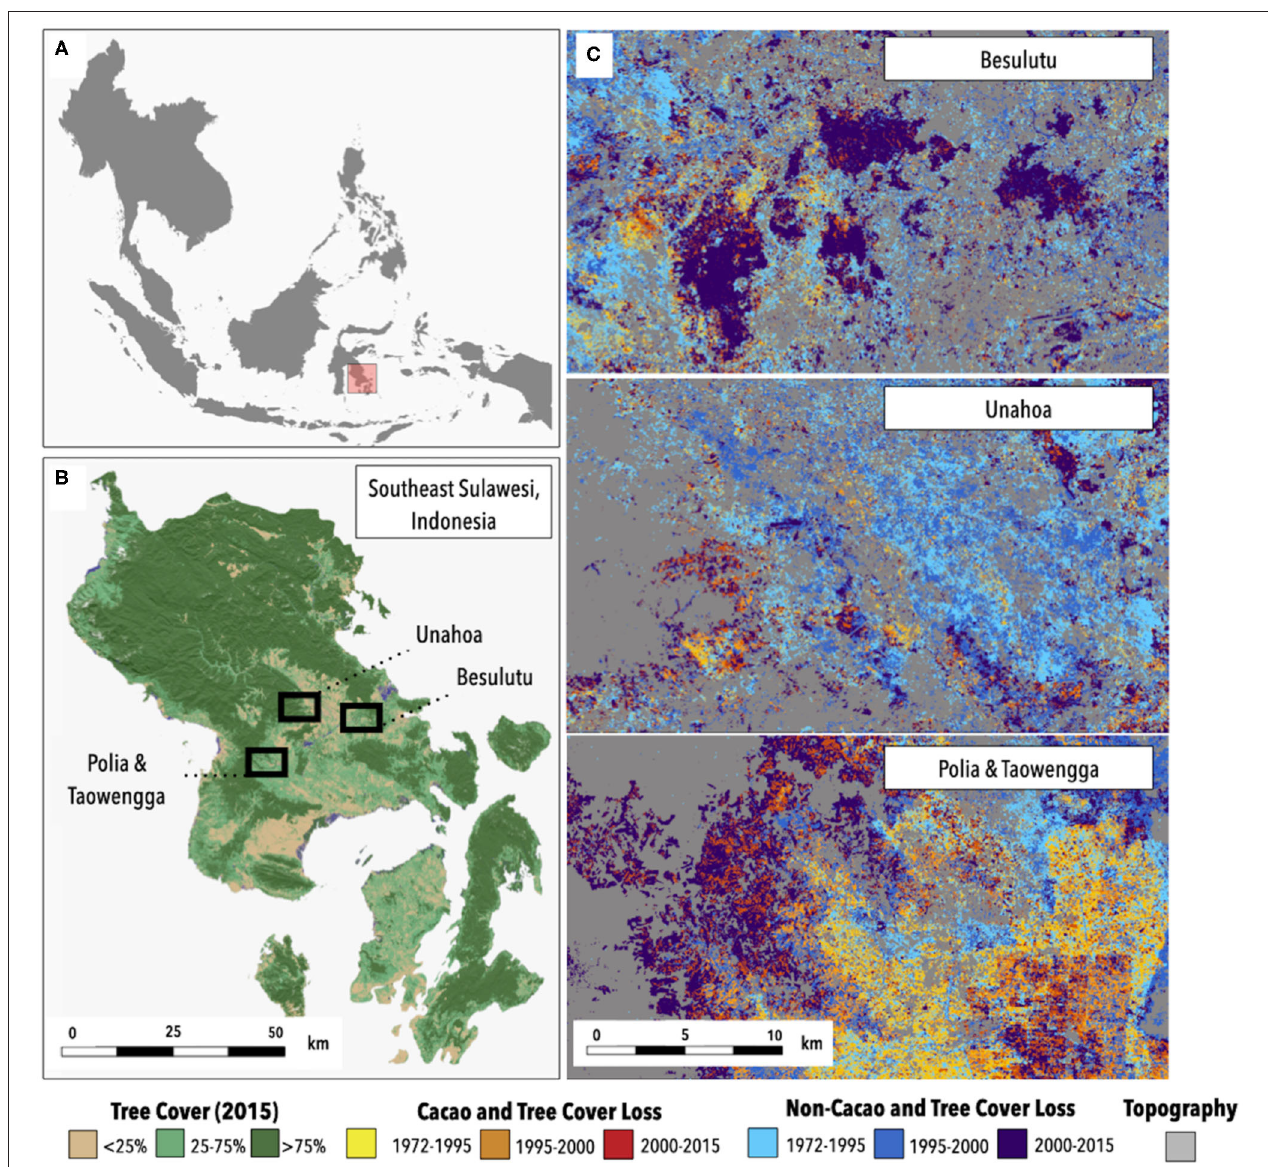
FIGURE 3 | Land Change Trajectories, 1972–2015. (A) depicts the study area in regional context, (B) visualizes the distribution of tree cover in the study areas, and (C) presents data on the overlap between cacao and non-cacao land covers (2015) and tree cover loss (1972–2015). Non-cacao land covers mapped through this approach include wet rice, built or impervious surfaces, other forms of tree crop production, and forested